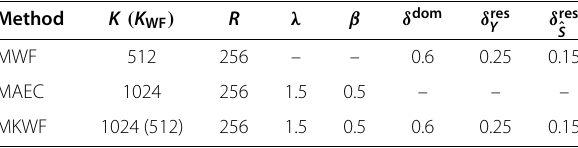
Table 1 Parameter configuration of the MWF, MAEC, and MKWF methods